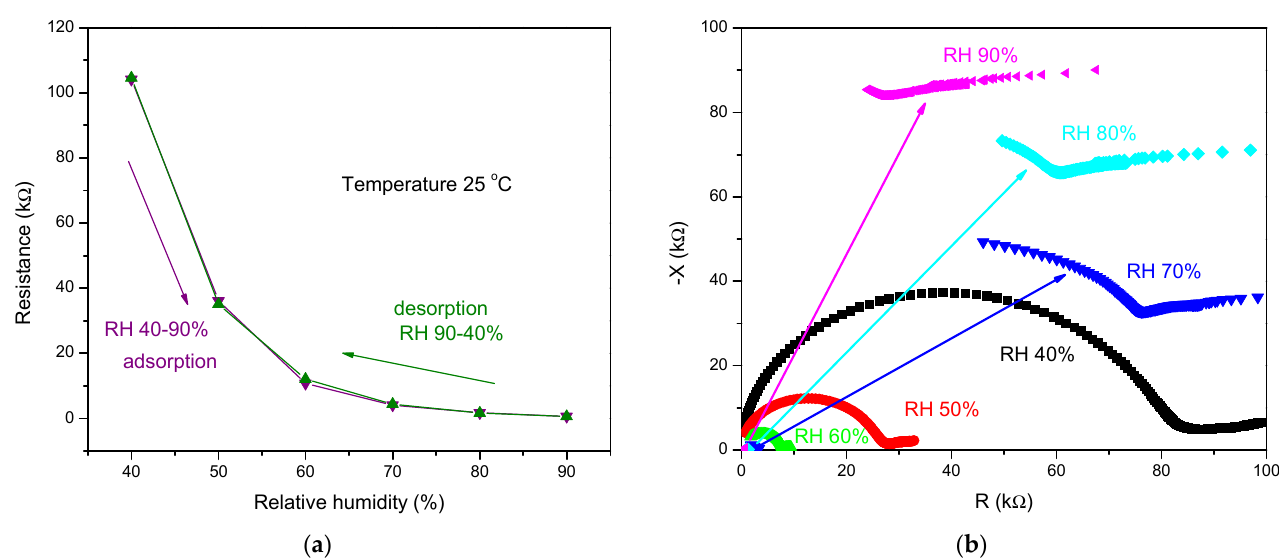
Figure 10. Adsorption and desorption curves obtained at 25 °C in the RH range 40–90% ( a ) and influence of change in RH on complex impedance ( b ).